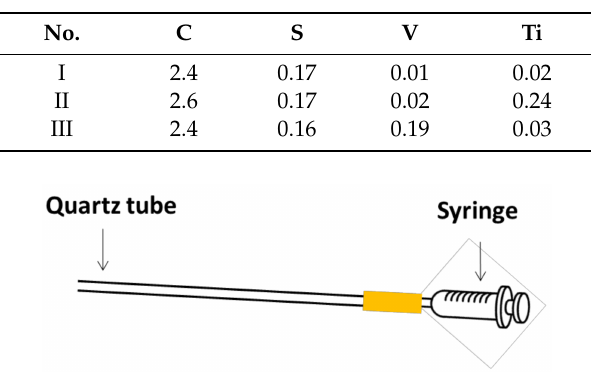
Table 3. Compositions of the liquid iron before reaction (wt. %).